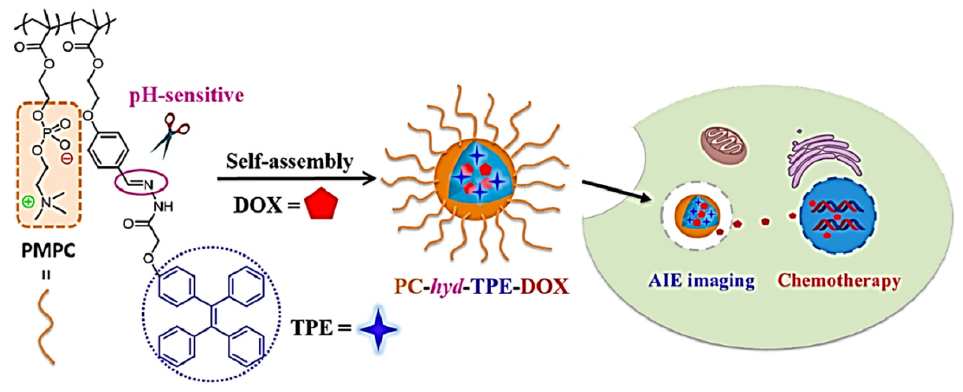
Figure 24. Structure of the molecule PC- hyd -TPE-DOX representing application for drug release and cell imaging. Reprinted from reference [135] with the permission of the American Chemical Society.